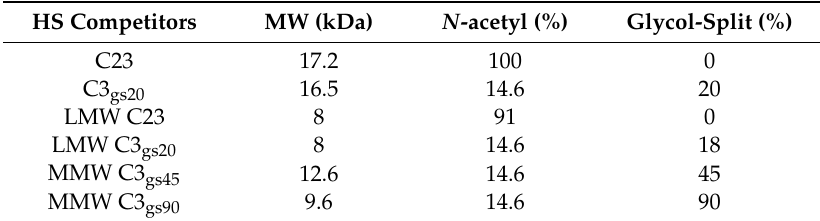
The average molecular weight (MW), percentage of N -acetyl substitution in glucosamine residues and percentage of glycol-split (gs) uronate residues (cleavage by periodate oxidation of vicinal diols in unsubstituted D -GlcA and L -IdoA residues) is reported. Samples MMW C3 gs90 and MMW C3 gs45 have been partially desulfated in order to increase the percentage of uronic acids reactive for the glycol-splitting modification. Samples LMW C23 and LMW C3 gs20 have been obtained by controlled reductive deamination of PMH. LMW, low MW; MMW, medium MW.